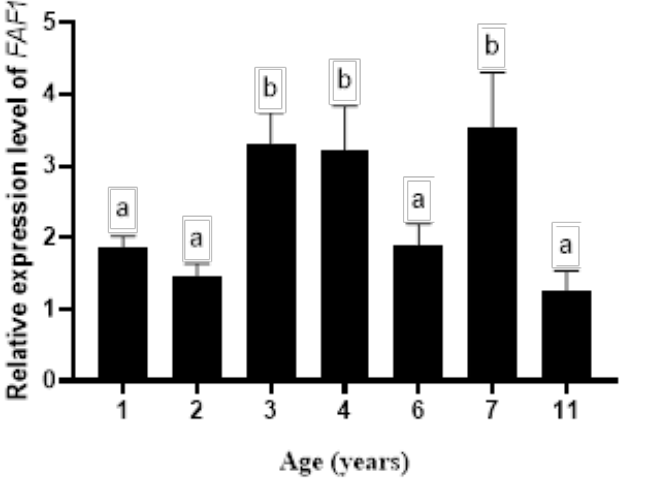
Figure 1. Relative expression levels of the FAF1 gene in testis tissues of different ages (different letters indicate significantly different values at p < 0.05).